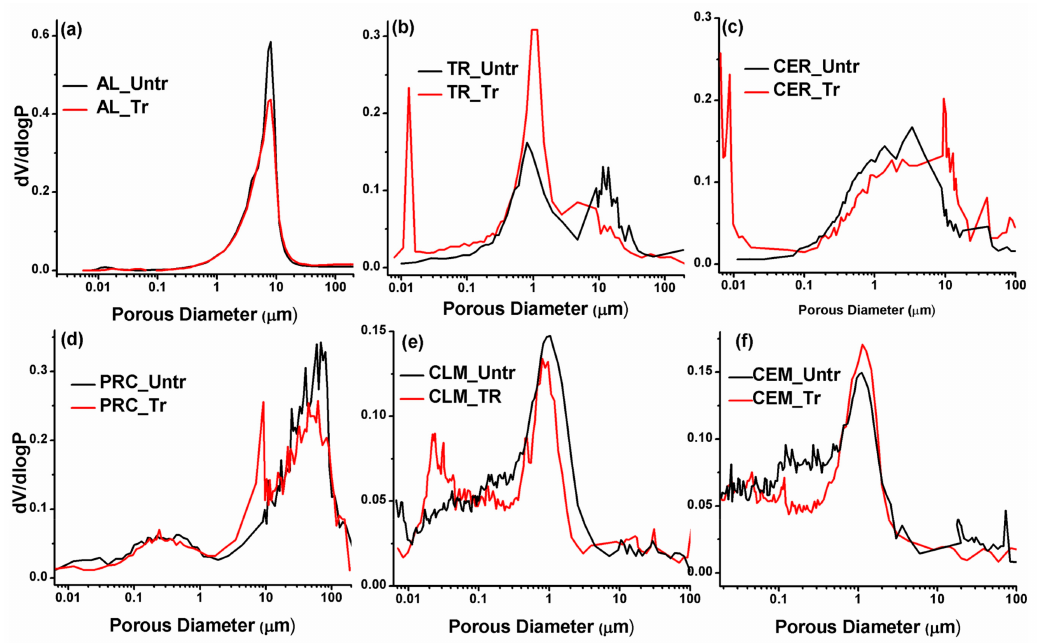
Figure 6. Representative graphs of pore size distribution, evaluated through Mercury Intrusion Porosimetry of: ( a ) AL; ( b ) TR; ( c ) CER; ( d ) PRC; ( e ) CLM and ( f ) CEM before and after consolidation with